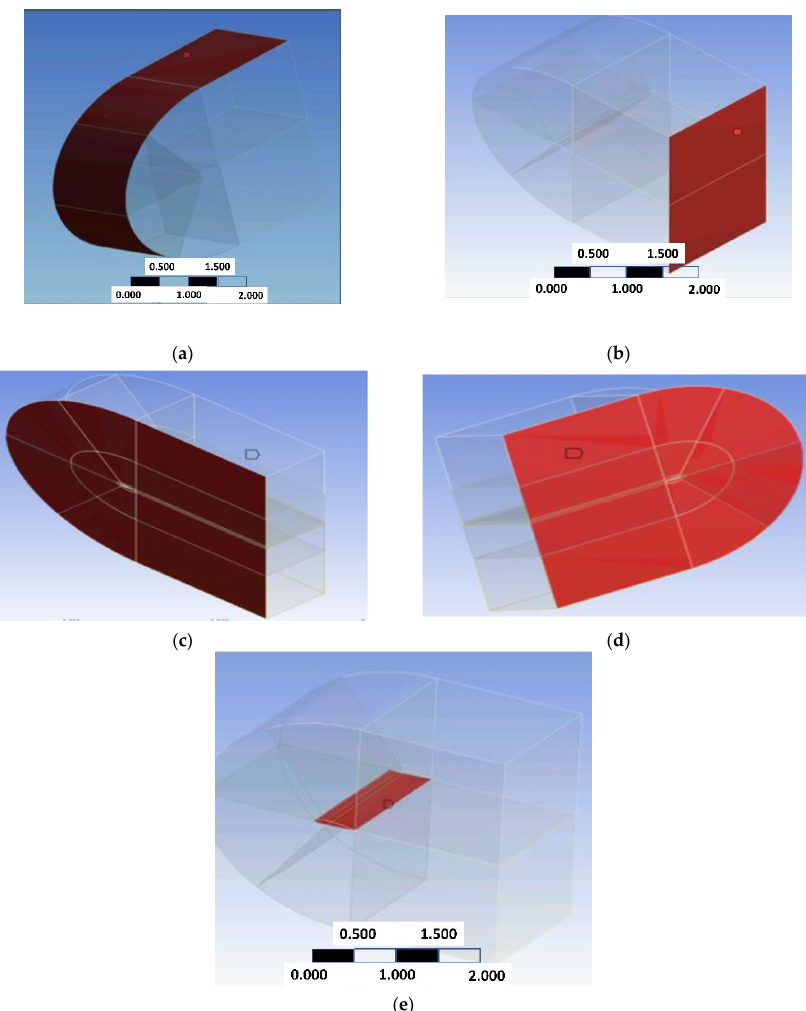
Figure 5. ( a ) input face and ( b ) outlet face. ( c ) the left side symmetry faces and ( d ) the right-side symmetry face. ( e ) Airfoil inside the computational domain.